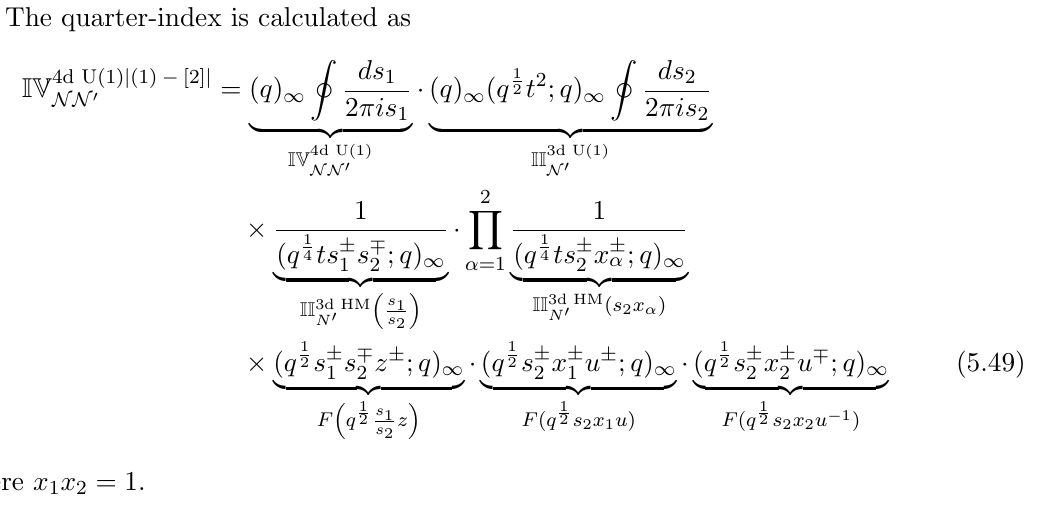
Figure 14 . The brane constructions of the configuration 4d U( N ) ( , N (cid:31) ) and its mirror corner configuration which involves Dirichlet b.c. N (cid:31) a three-dimensional U( M ) gauge